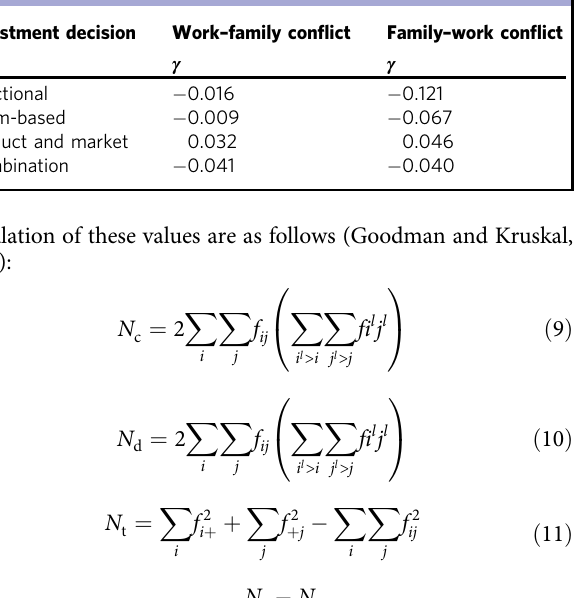
Table 9 Gamma coef fi cient values for investment decisions and con fl